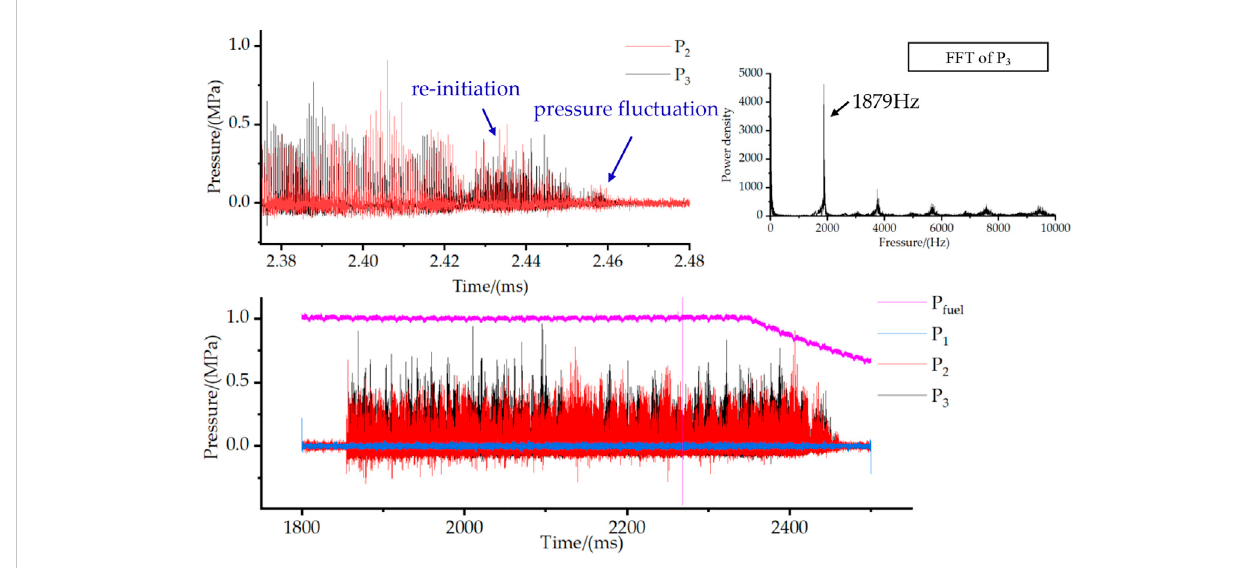
FIGURE 13 Results of operating at ER = 1.1 and l w = 4 mm.